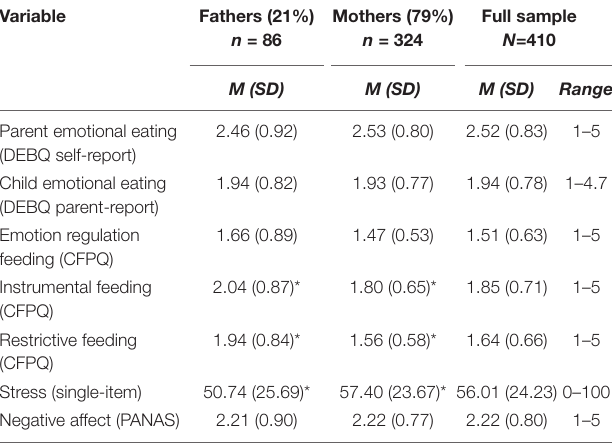
TABLE 4 | Model comparison results for conditional indirect effects.